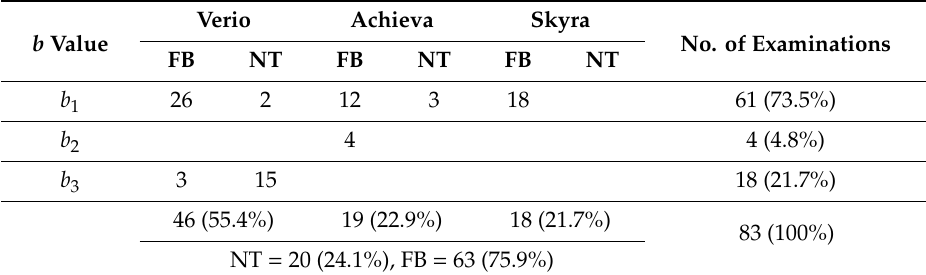
Table 2. DWI acquisition methods.